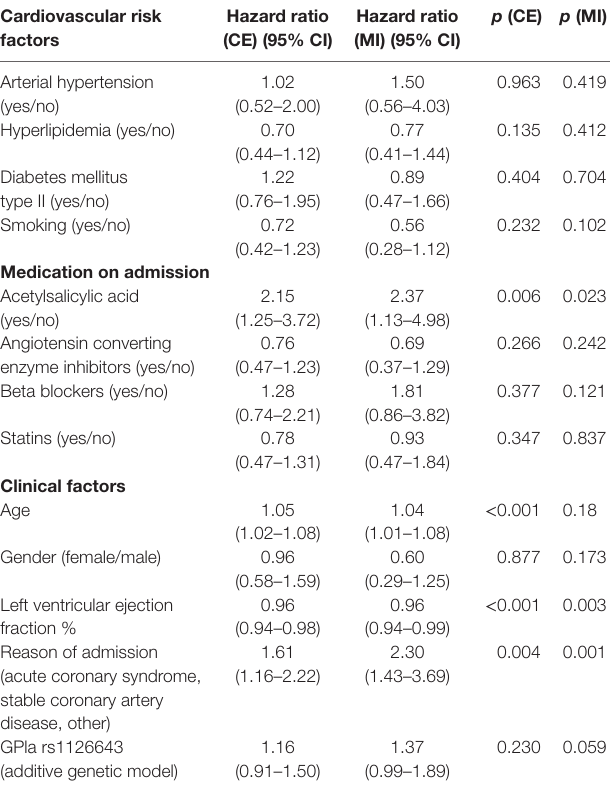
TaBle 4 | Cox regression analyses for the combined endpoint (CE) or myocardial infarction (MI) as dependent variable, rs1126643 (additive genetic model) as independent variable, and clinical factors as covariates in the overall cohort of cardiovascular patients ( n =